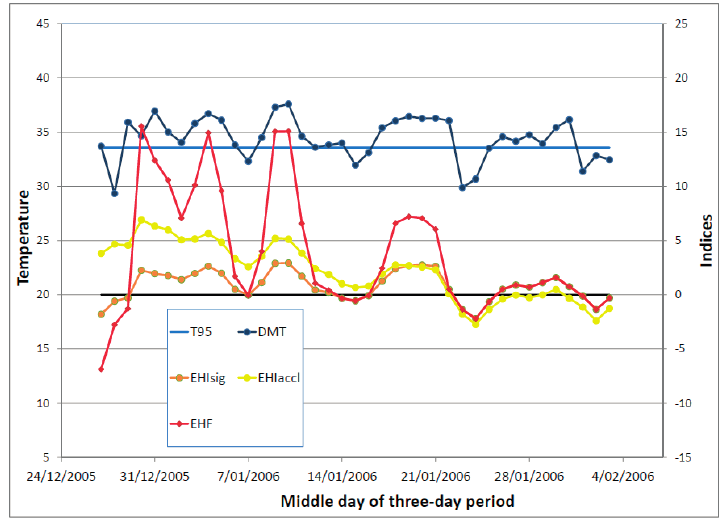
Figure 5. An actual period of extended heatwave activity at Oodnadatta (South Australia) in late 2005/early 2006. The DMT hovers around the heatwave threshold for the EHI exceed the EHI , and for EHI to become negative while heatwave conditions are in accl accl place. Data are obtained from interpolated gridded